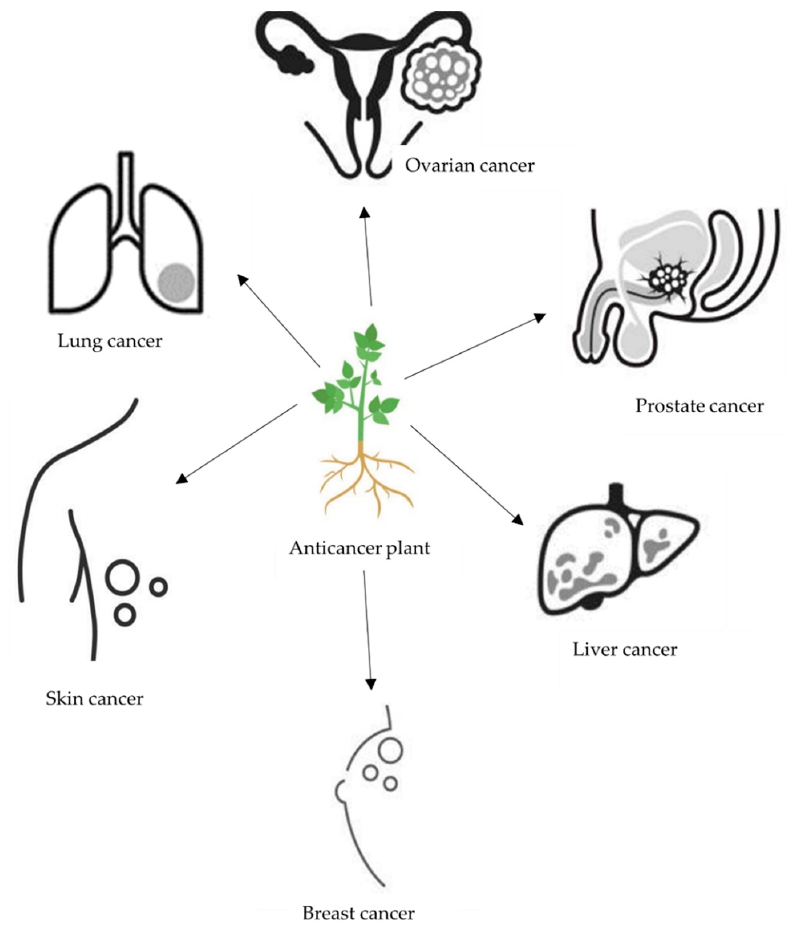
Figure 1. Illustration of anticancer plant use against some cancers.